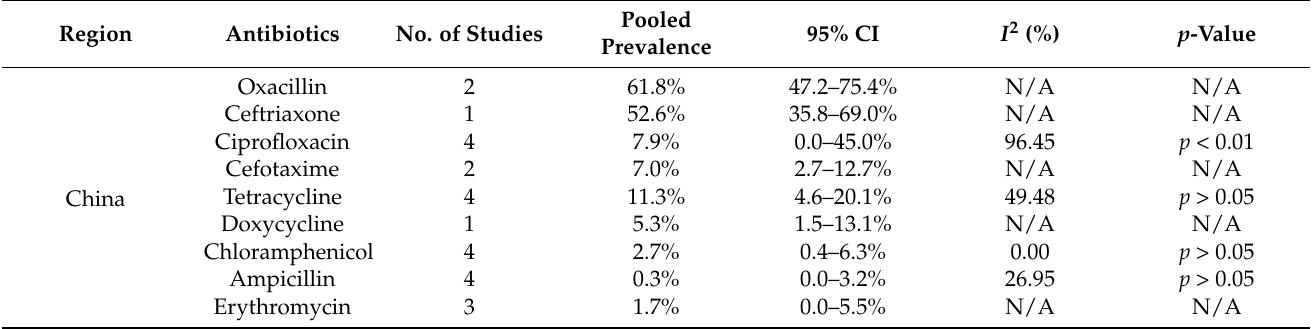
Table 9. Subgroup analysis of the prevalence antimicrobial resistance of L. monocytogenes towards different